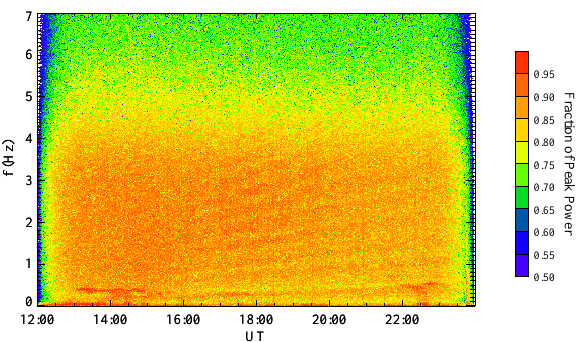
Fig. 2. Pulsation magnetometer data for 04/10/98 from Sodankyl¨a, Finland displayed as colour dynamic power spectral plot for the east west (D component) polarisation. The window and slip size are 100s; power spectral density is normalised to peak power at 3Hz and not calibrated.